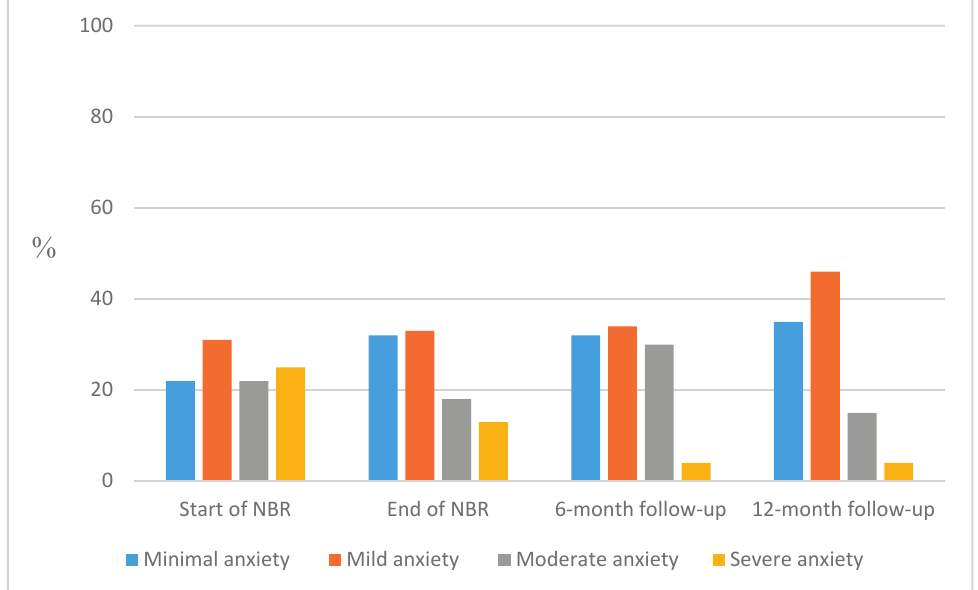
Figure 6. Proportions of participants with grand sum according to the standardized cut-offs for BAI: minimal (0–7), mild (8–15), moderate (16–25) and severe (26–63) anxiety measured at start of NBR and follow-up at end of NBR, and after six and twelve months, respectively.